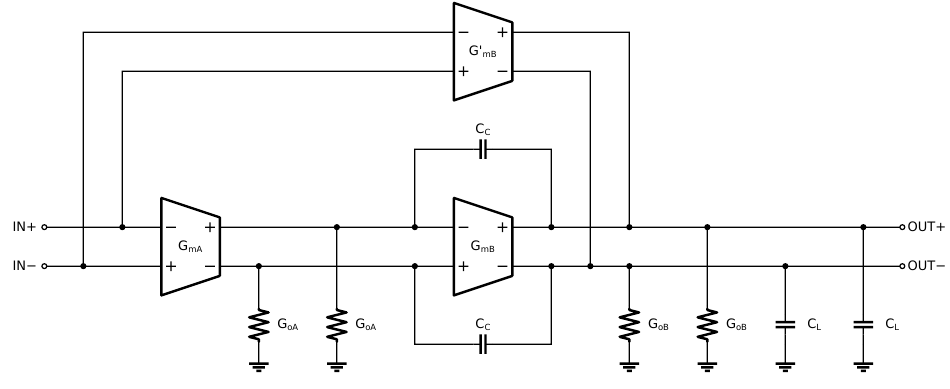
Figure 11. Two-stage amplifier with Gm-C feedforward frequency compensation [17]. Equation (21) shows the open-loop transfer function for the number of stages n =